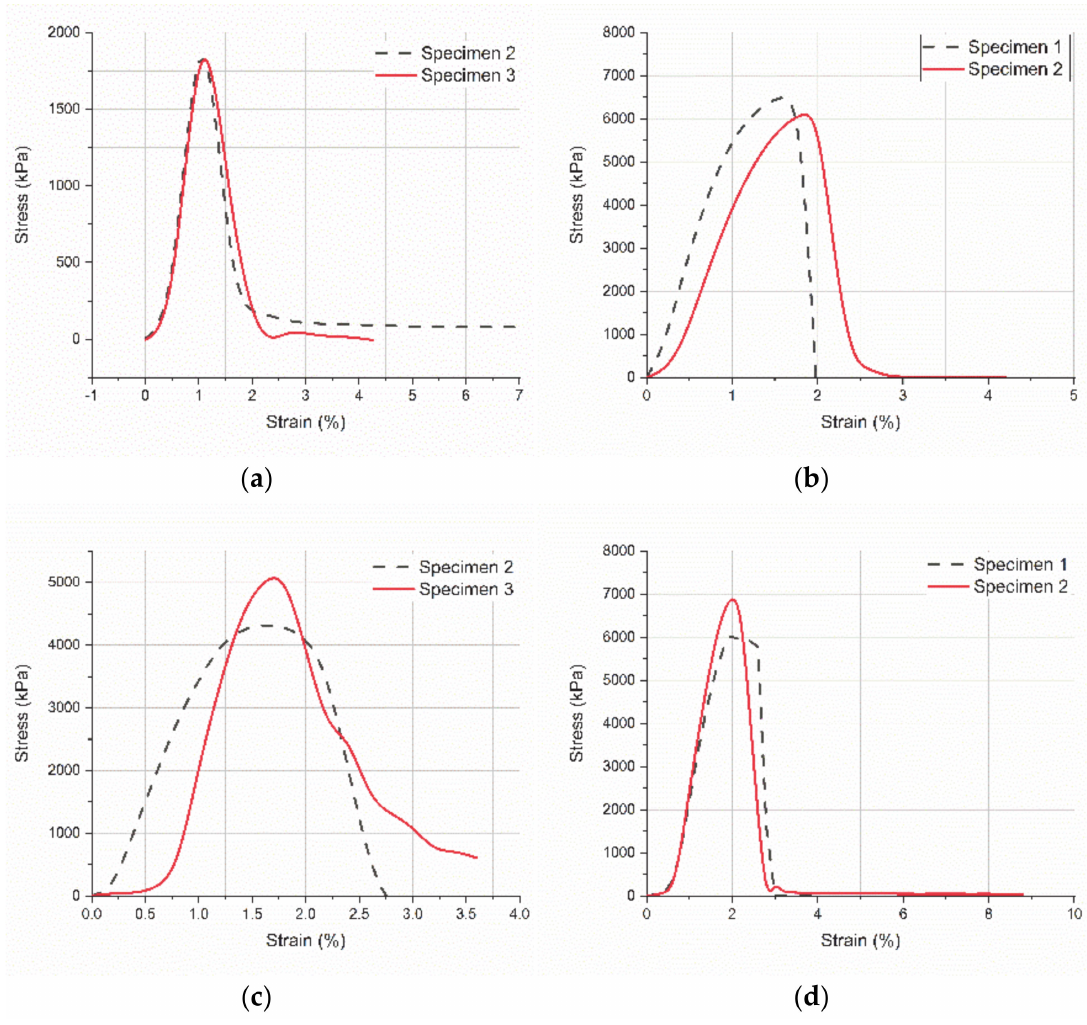
Figure 7. Stress-strain curves for single lap joints (micro-tensile tests): ( a ) Titanium-PLA, ( b ) TNTs-PLA; ( c ) Titanium-PLA after 8 h immersion in SBF, and ( d ) TNTs-PLA after 8 h immersion in SBF.